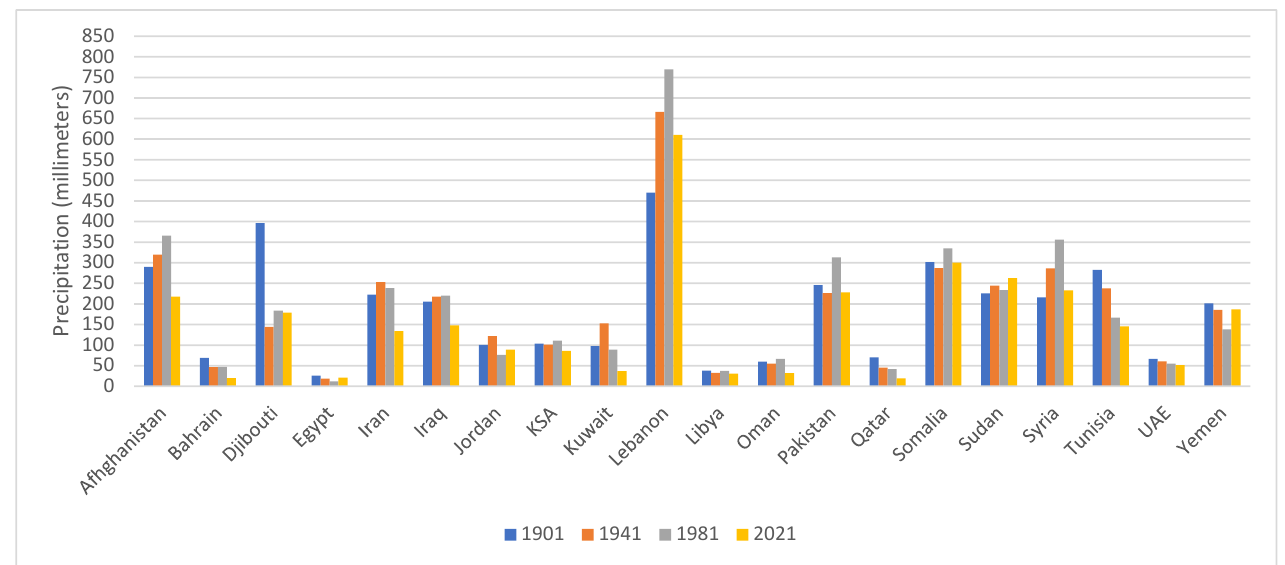
Figure 2. Trend in annual precipitation (millimeters/year) in various countries of the EMR. Data retrieved from the World Bank Climate Change Knowledge Portal [21–40]. Abbreviations: EMR: Eastern Mediterranean Region; KSA: Kingdom of Saudi Arabia; UAE: United Arab Emirates.